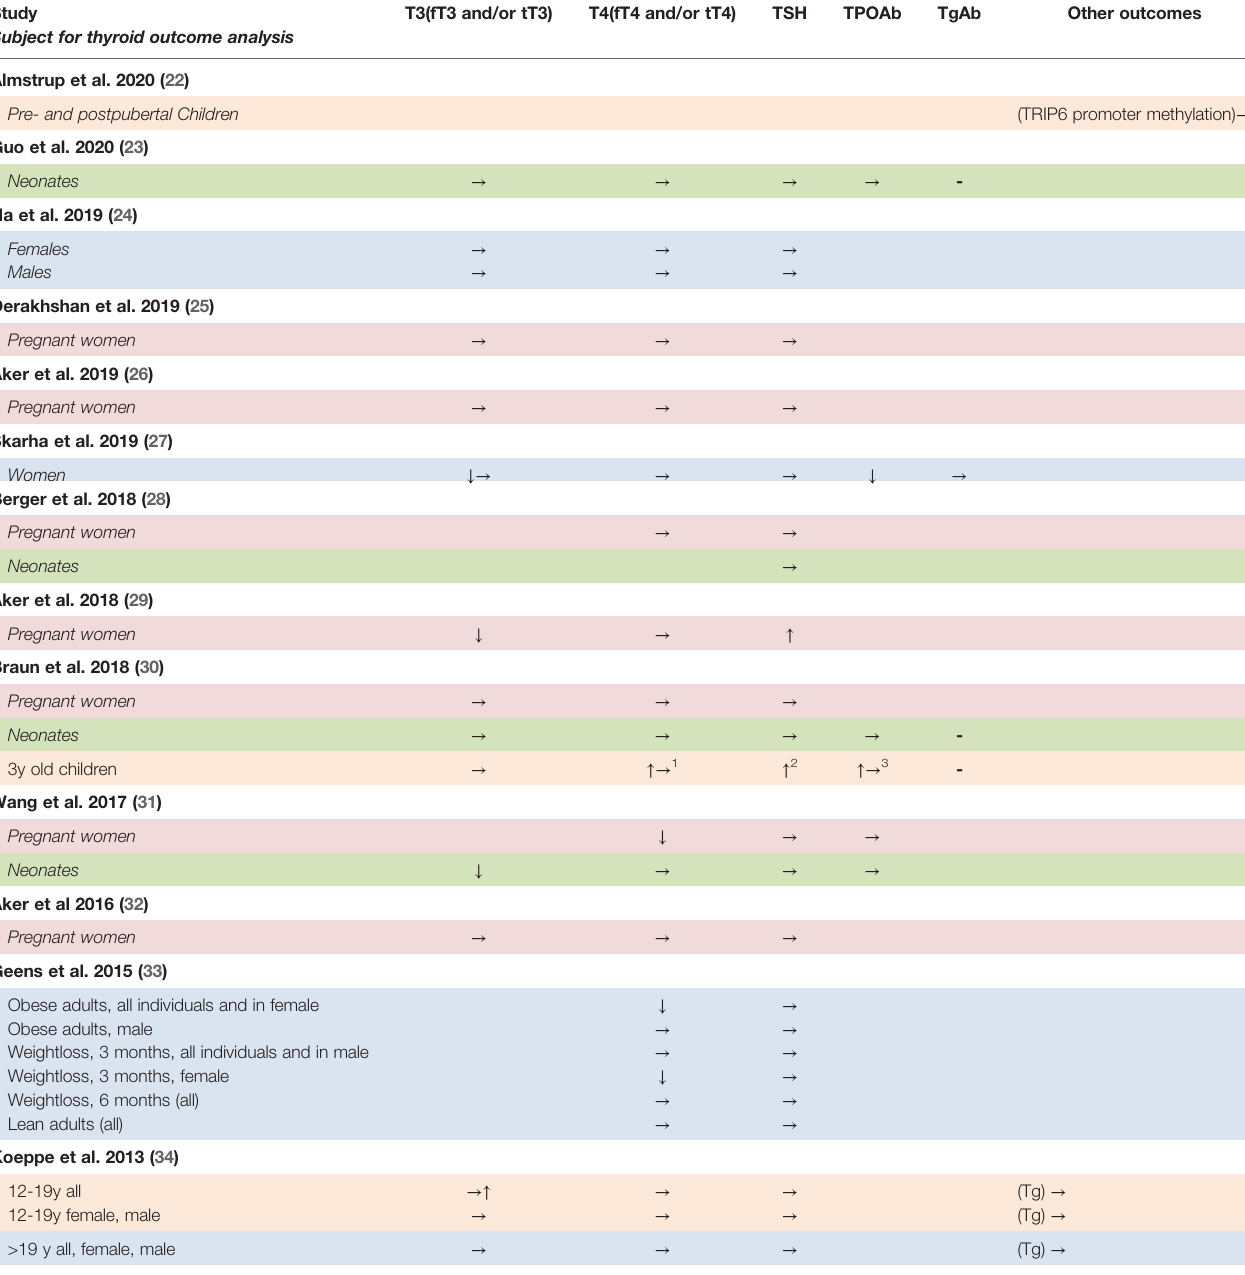
TABLE 2 | Summary of fi ndings of associations between triclosan concentrations and thyroid hormone system variables in observational studies of adult